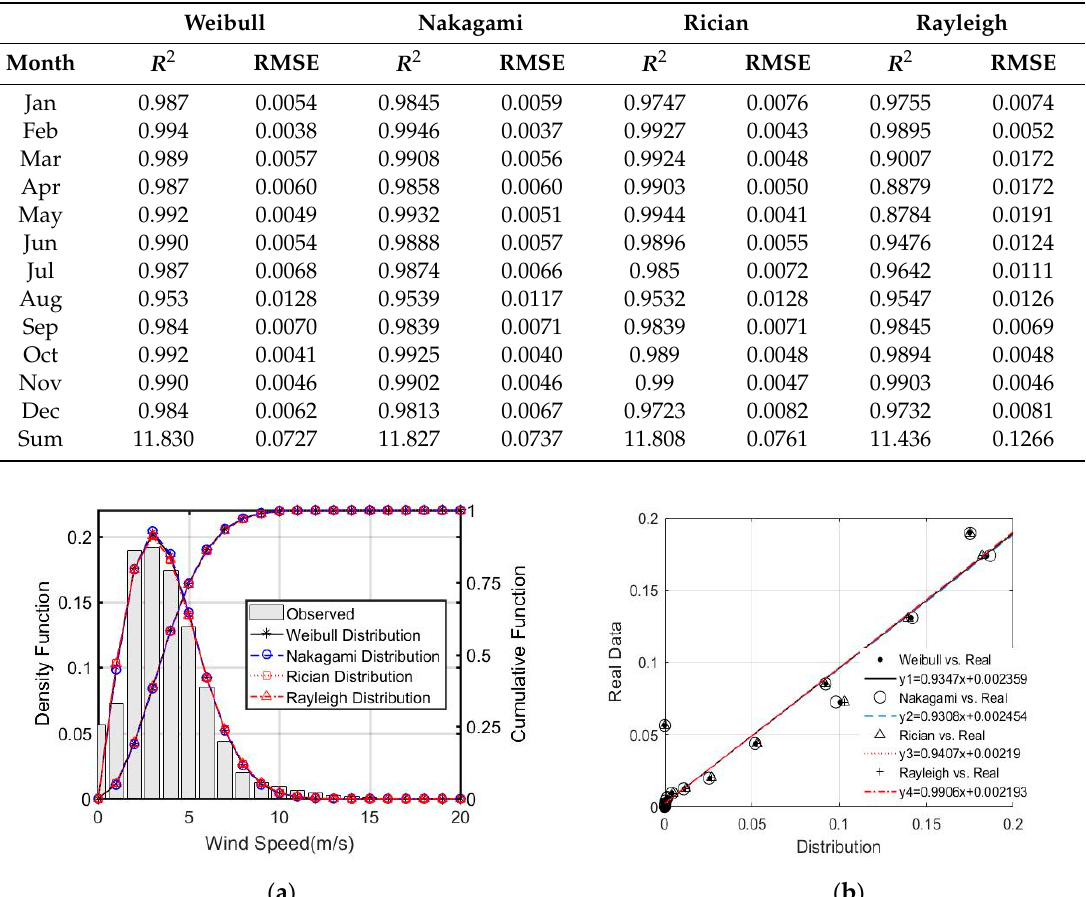
Table 9. Error evaluation of PDFs in each month.